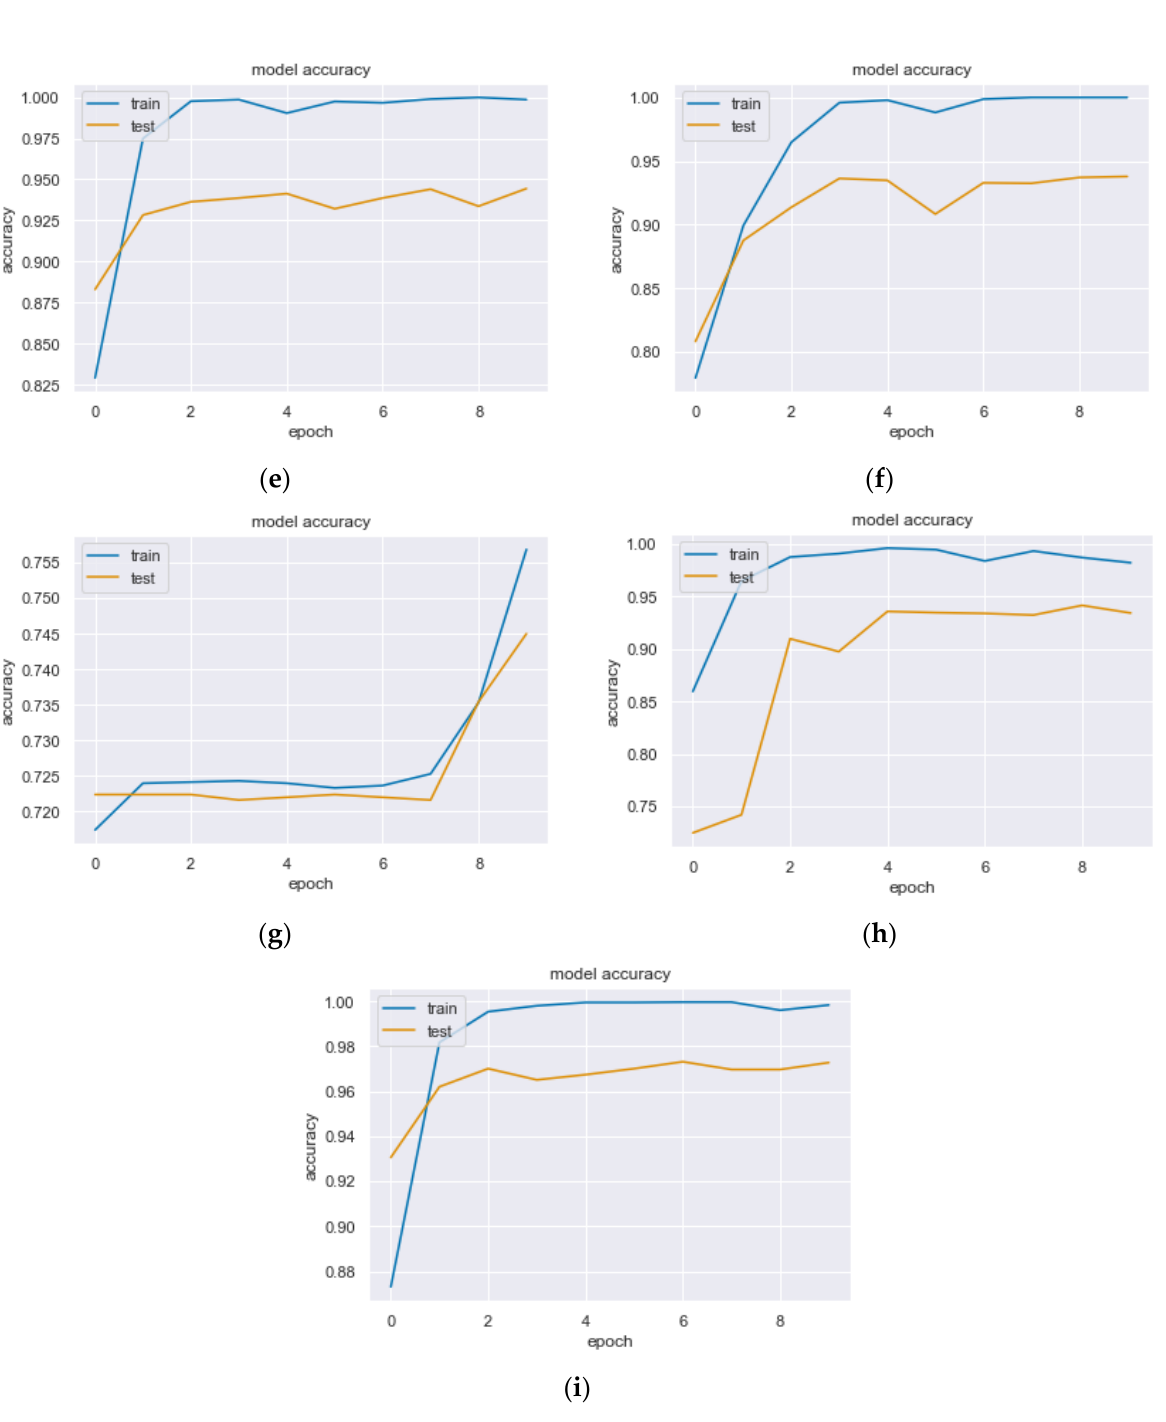
Figure 5. Performance curves of various models for gender classification when trained with facemask images where individuals either wear the mask fully, half, or partially (3 ways/styles of wearing). Accuracy curves for ( a ) DenseNet121; ( b ) DenseNet169; ( c ) Xception; ( d ) InceptionV3; ( e ) ResNet50; ( f ) ResNet101; ( g ) VGG16; ( h ) MobileNetV2; ( i ) EfficientNetB0.